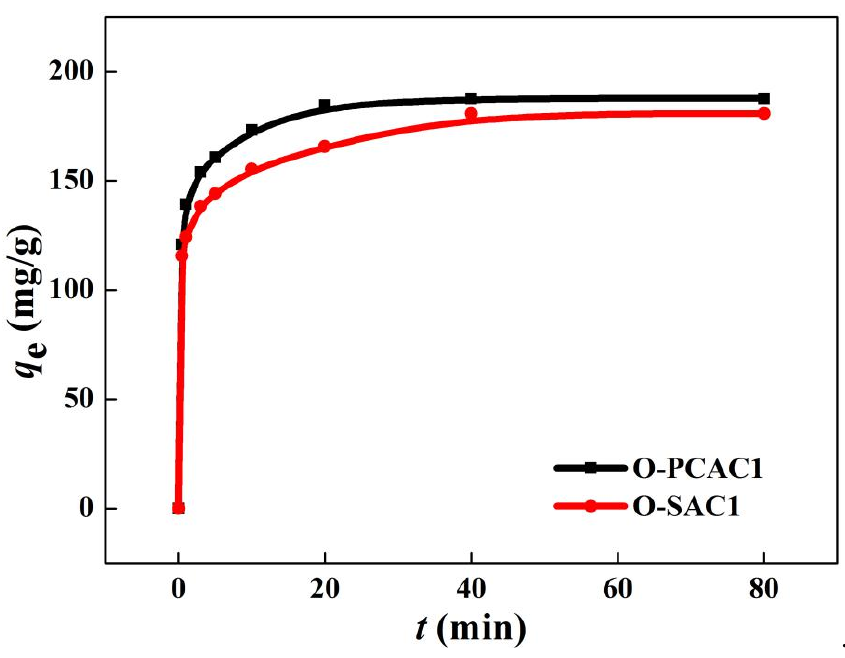
Figure 4. The effect of contact time on the adsorption capacity of in situ modified activated carbons (IMACs). Table 6. Langmuir and Freundlich isotherm model constants and correlation coefficients (303 K) Table 4. Kinetics parameters of NAP adsorption onto IMACs at 303 K.